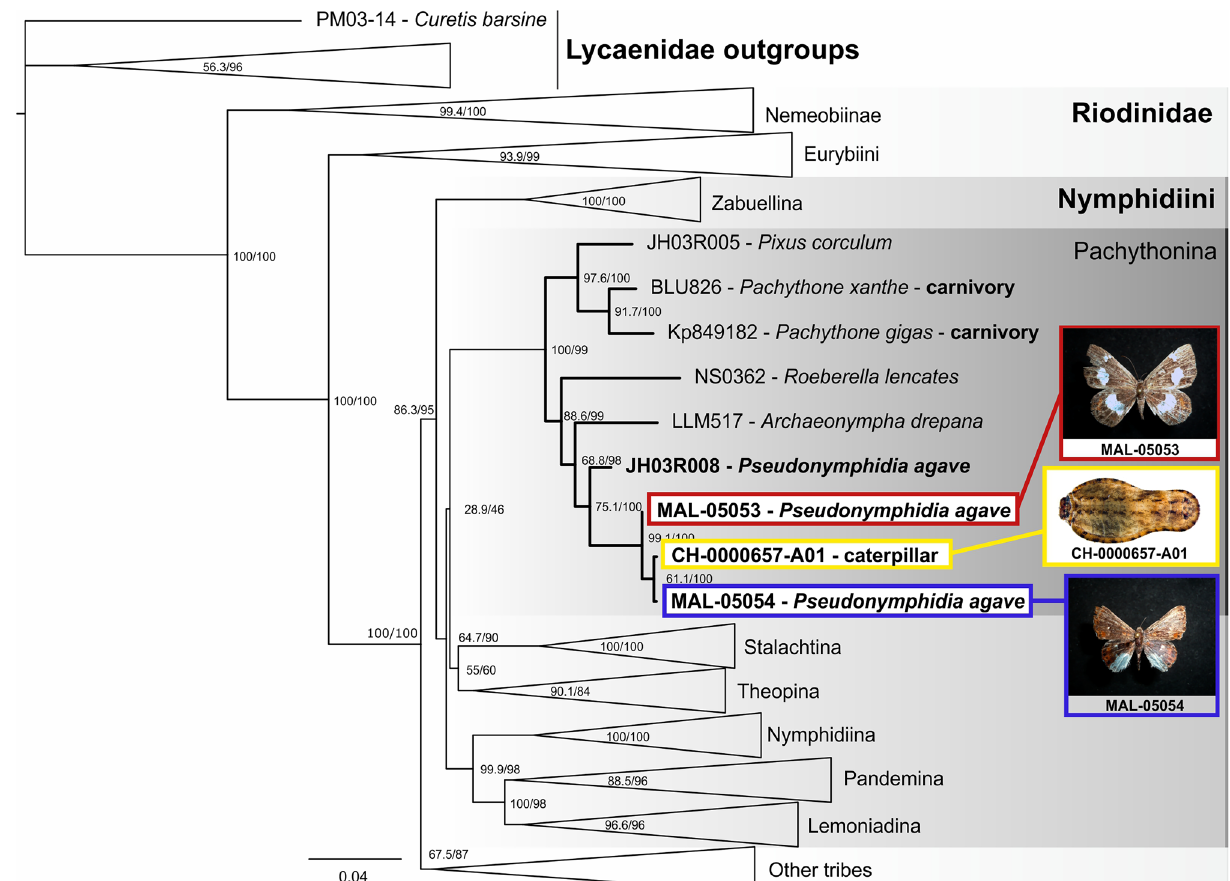
Figure 2. Maximum likelihood tree of the Riodinidae, used to identify the collected larva, showing its systematic position within the subtribe Pachytonina. The remaining clades within the Riodinidae have been compressed for clarity. Pseudonymphidia agave sequences are illustrated with photos of the adults: MAL-05053, MAL-05054 (Photos: B. R. Prado-Cuellar) and the caterpillar (Photo: H. Bahena